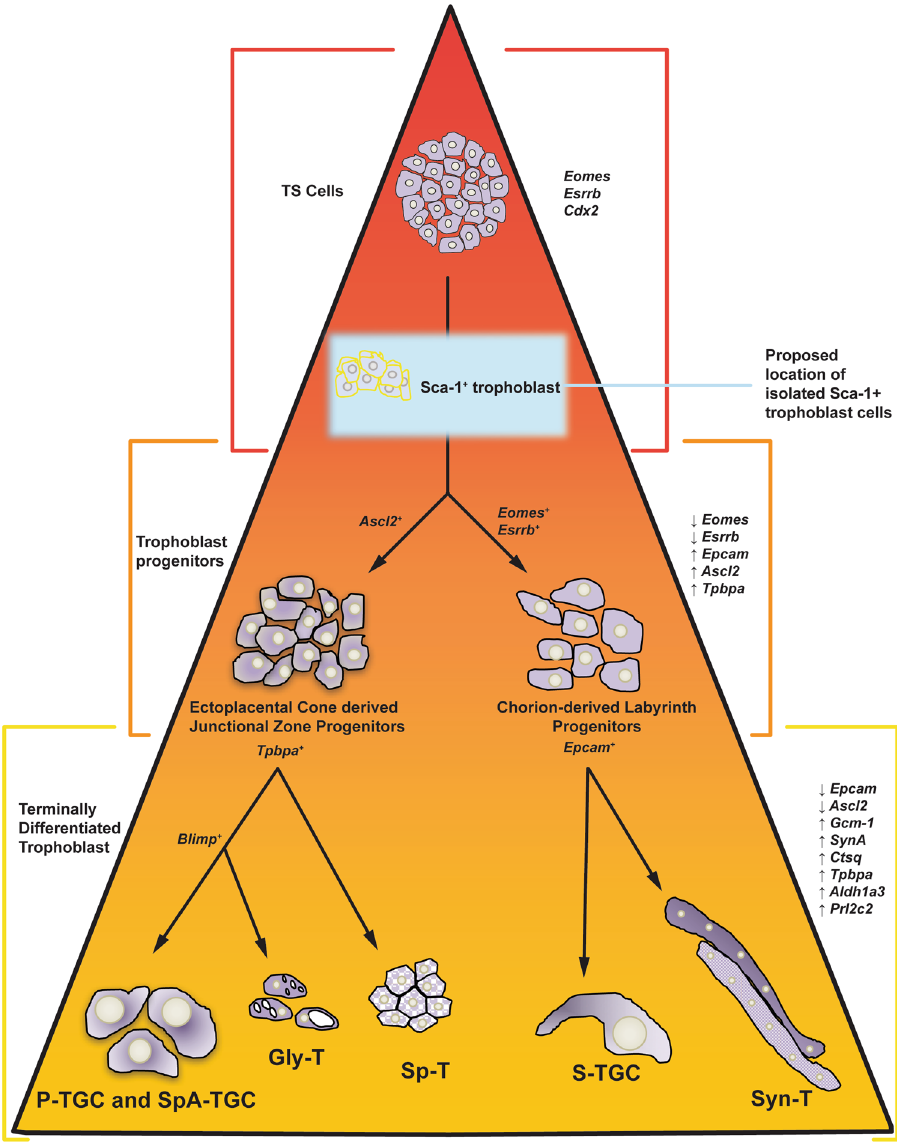
Figure 10. Cartoon depicting proposed position of Sca-1 + cells within the mouse trophoblast stem cell lineage. P-TGC, parietal trophoblast giant cell; SpA-TGC, spiral artery-associated trophoblast giant cell; Gly-T, glycogen trophoblast; Sp-T, spongiotrophoblast; S-TGC, sinusoidal trophoblast giant cell; Syn-T,